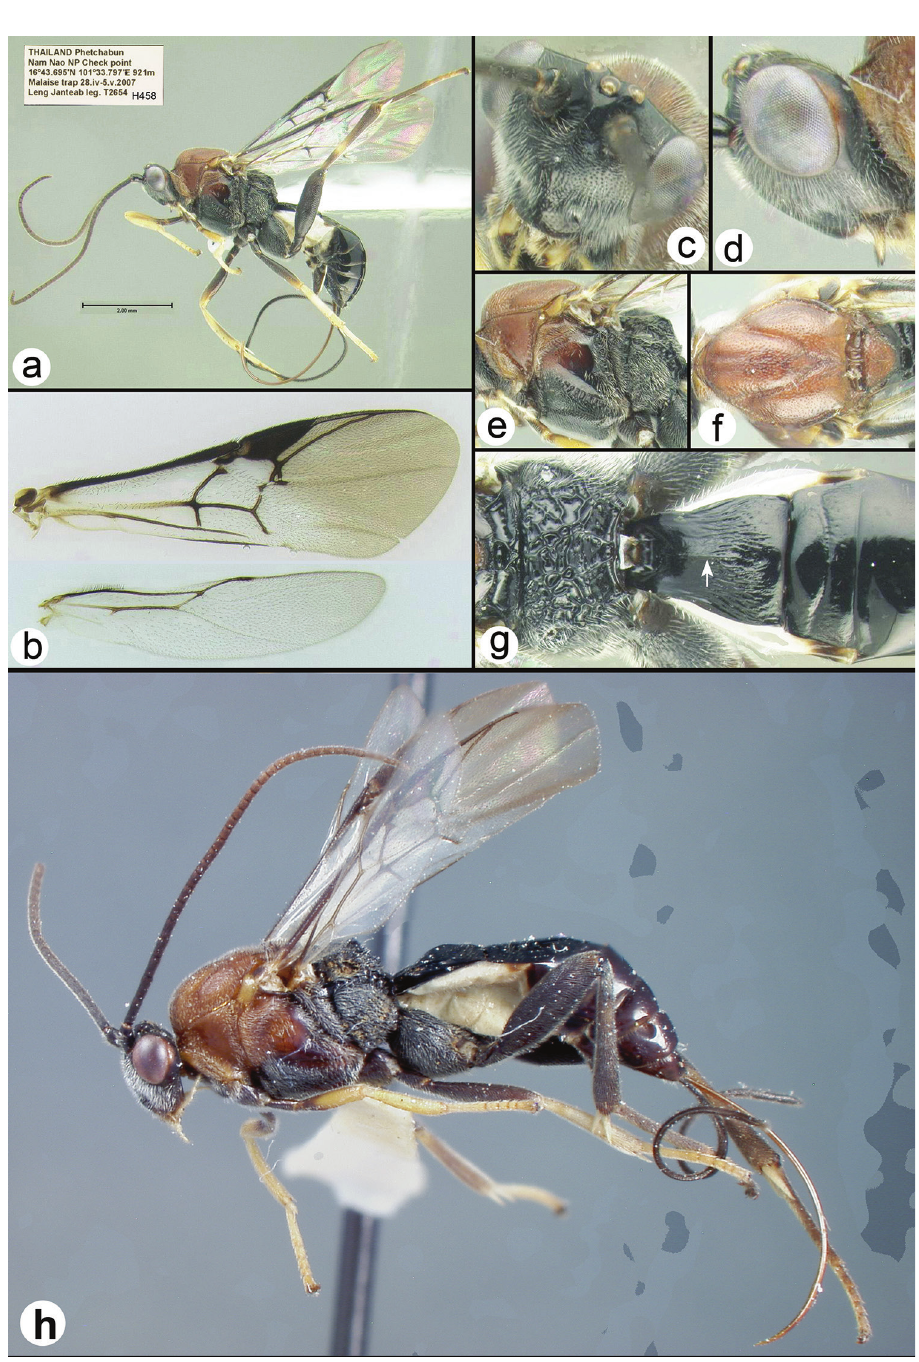
Figure 13. Liragathis javana female: a lateral habitus b wings c dorsal head d lateral head e lateral meso- soma f dorsal thorax g propodeum and metasomal terga 1-3 h holotype lateral